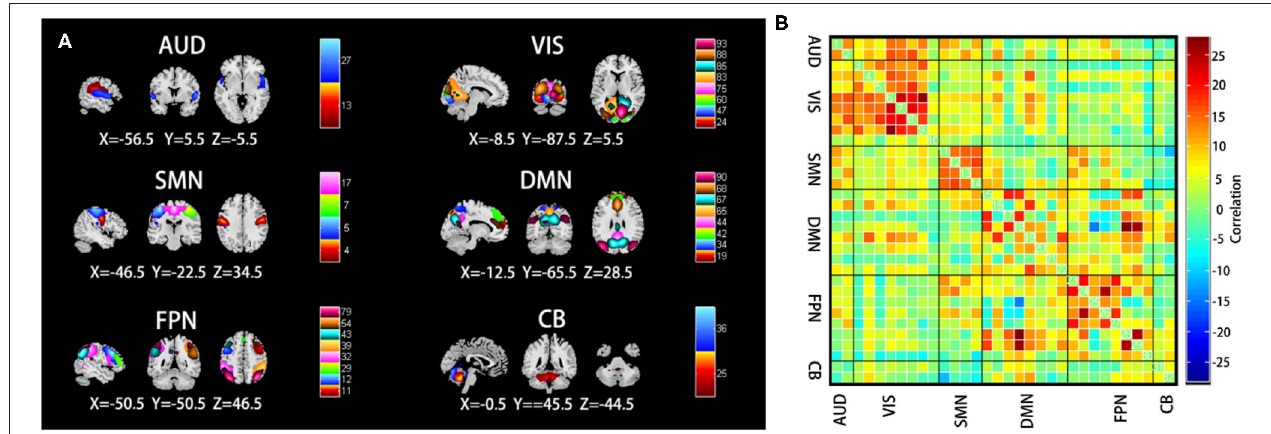
FIGURE 3 | (A) Selected the spatial maps of the internal connectivity networks, auditory network (AUN), visual network (VIS), sensorimotor network (SMN), default mode network (DMN), frontoparietal network (FPN), and cerebellar (CB). (B) The average resting-state functional connectivity matrix of all the subjects. The color bar represents the z -value of the functional connectivity. Hot colors indicate positive correlation, while winter colors indicate negative